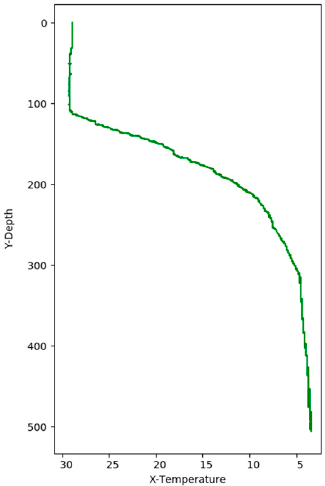
Figure 9. Correlation between depth and temperature.